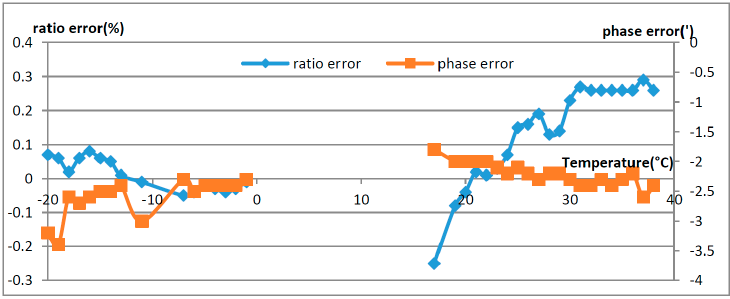
Figure 13. Error comparison of OVT in summer and winter.